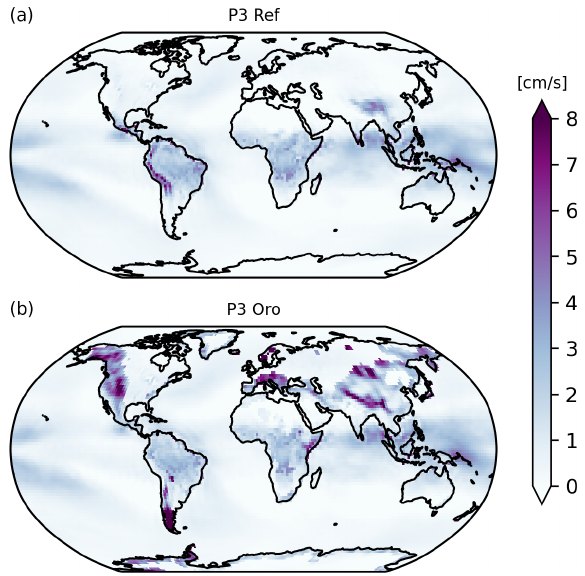
Figure A4. Five-year annual mean spatial distributions of the total vertical velocity as calculated in the P3 ice microphysics scheme and sent to the cirrus ice nucleation scheme at the 200hPa level for (a) P3 Ref without the orographic velocity component activated and (b) P3 Oro with the orographic component of the vertical velocity